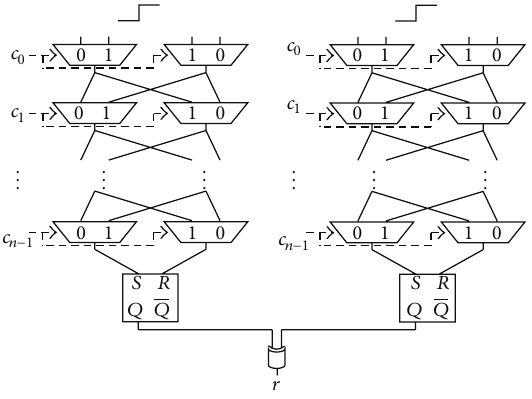
Figure 4: Structure of the 2-XOR Arbiter